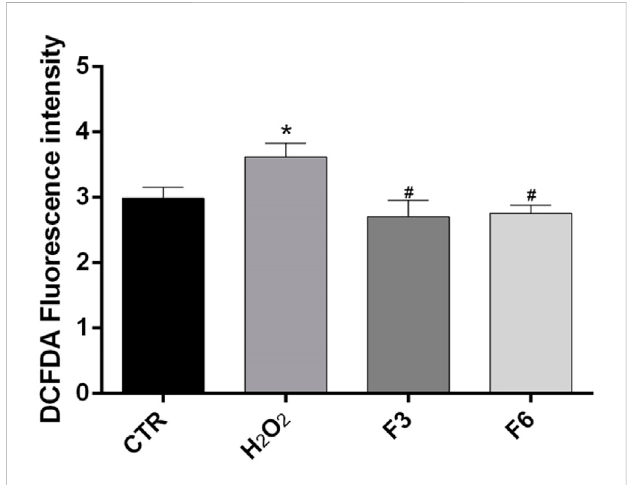
FIGURE 2 Detection of intracellular ROS production in corneal